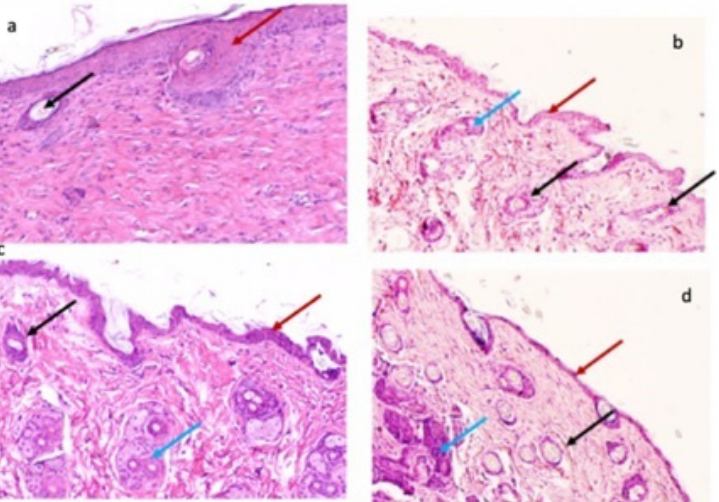
Figure 12. Hematoxylin and eosin staining of tissue wound area. Murine tissue treated with CTS-g- GMA ( a , c ) and ((CTS-g-GMA)-AuNPs) 0.3 mM ( b , d ) at 15 and 30 days after surgery. The red arrows show the epidermis, black arrows show hair follicles, and blue arrows indicate the formation of new blood vessels. Magnification: 10× to improve visualization.